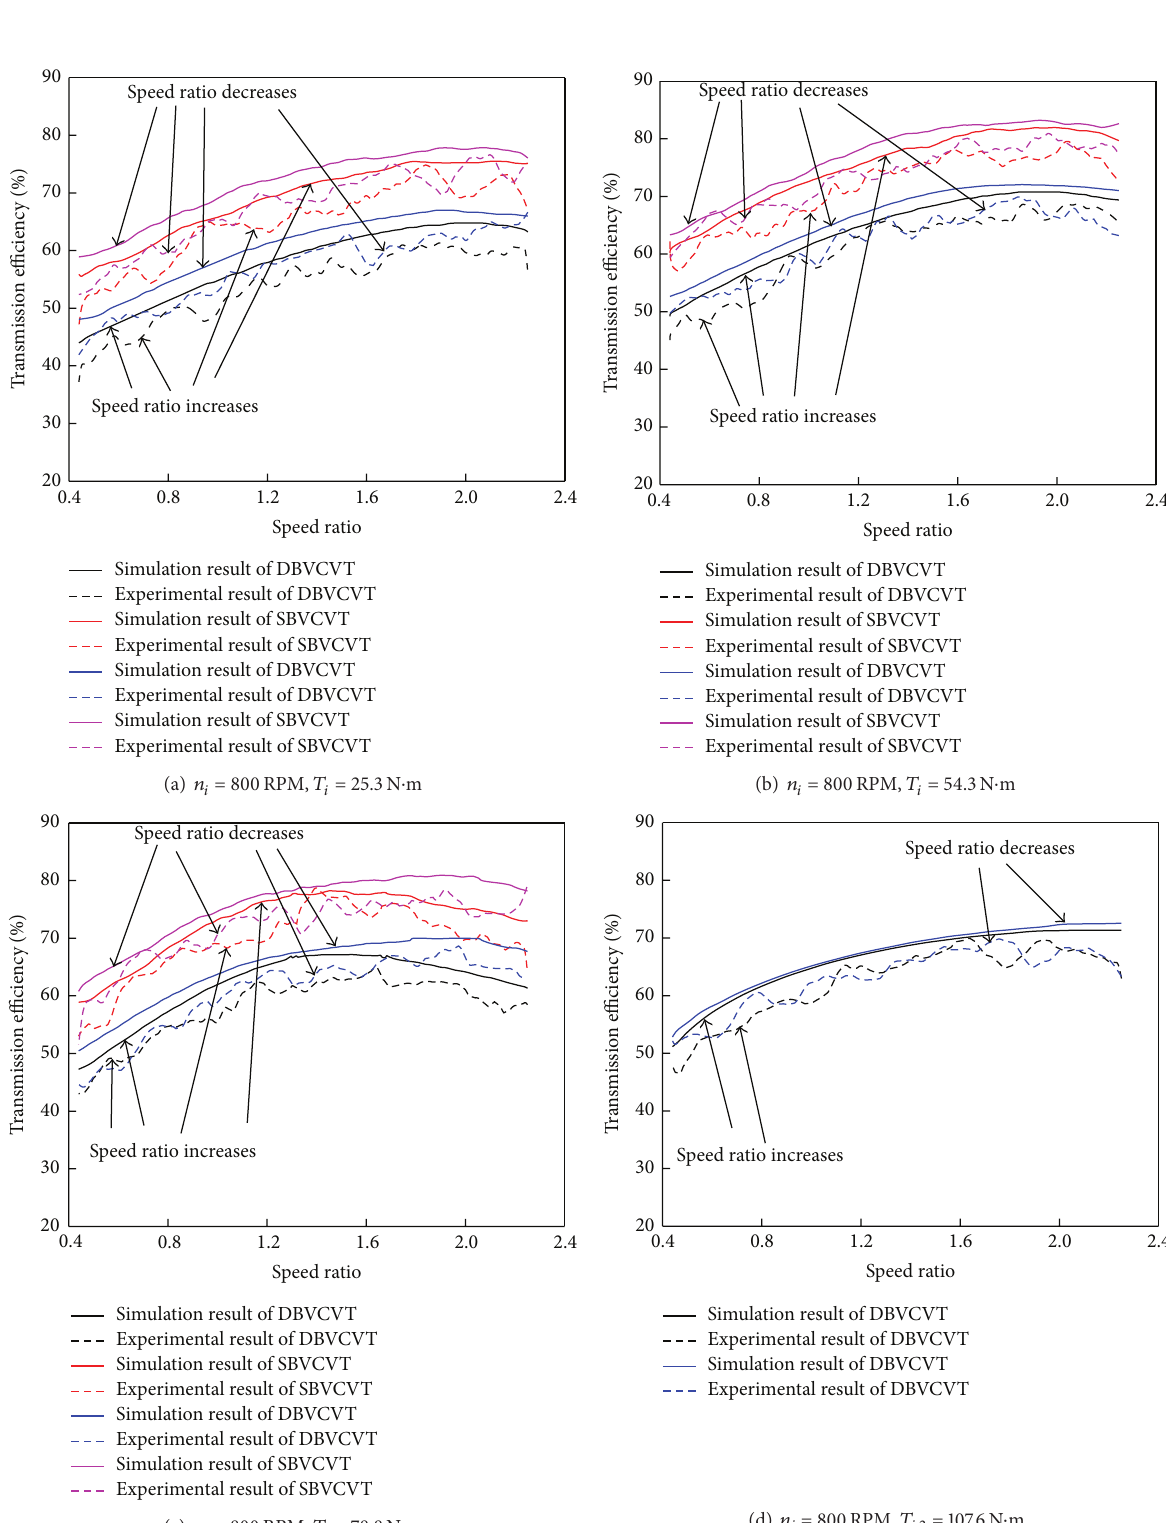
Figure 13: Comparison of simulation and experimental results of transmission efficiencies under 𝑛 𝑖 =